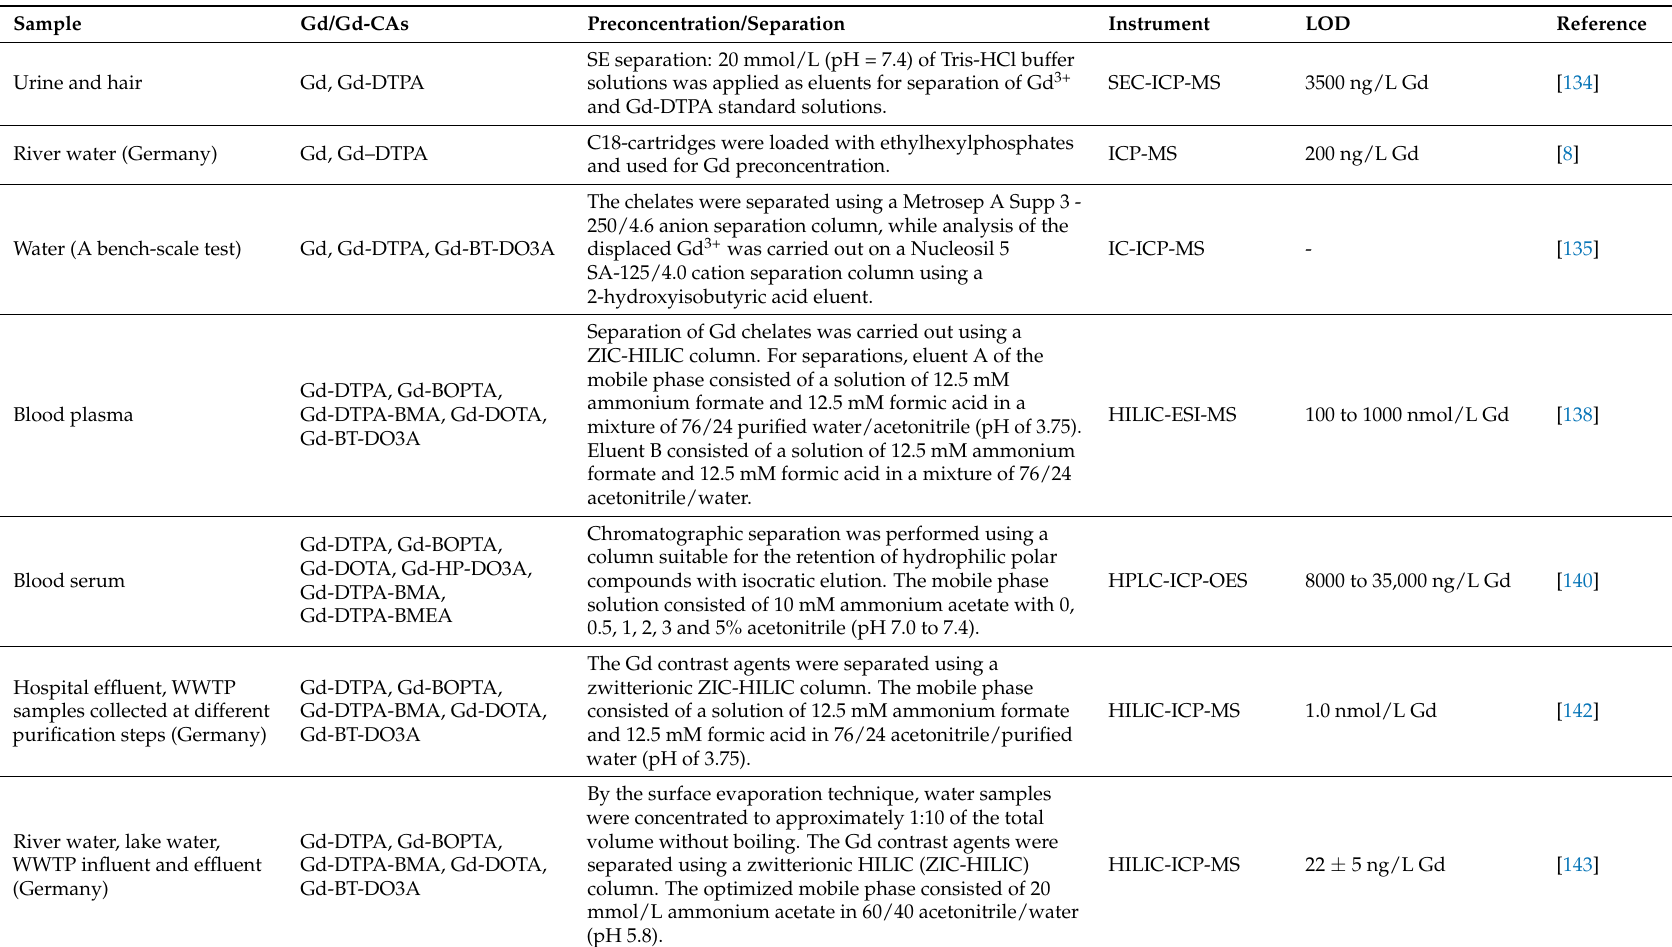
Table 5. Speciation analysis for the determination of different Gd-CAs in biological and environmental